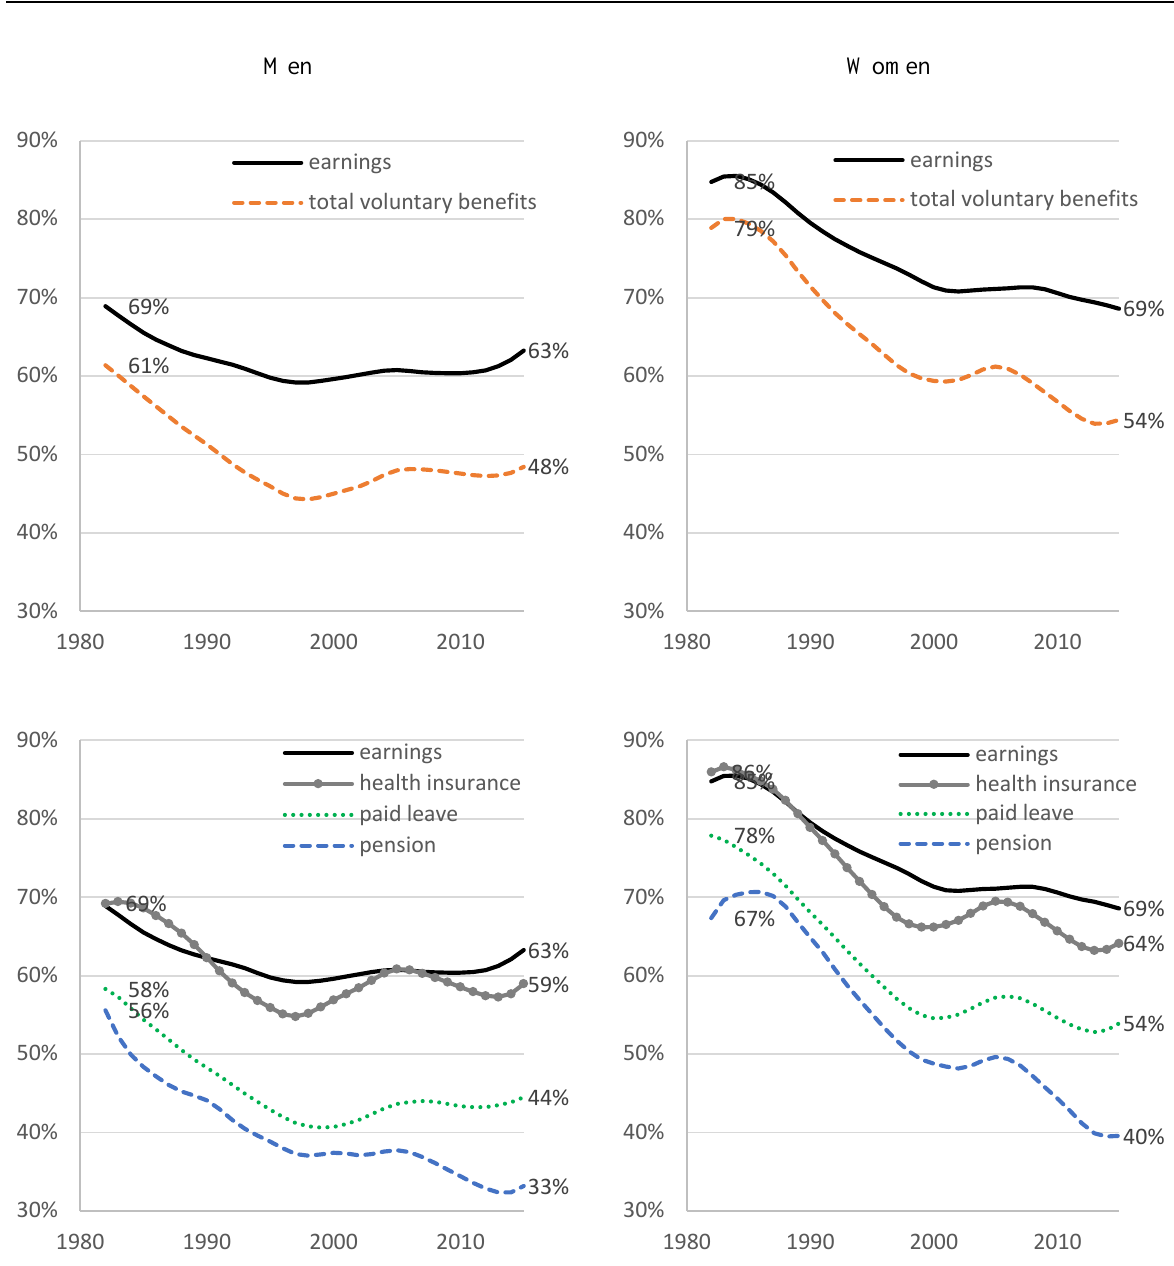
Figure 6: Hispanic-to-white health insurance, pension, paid leave, and total voluntary benefits and